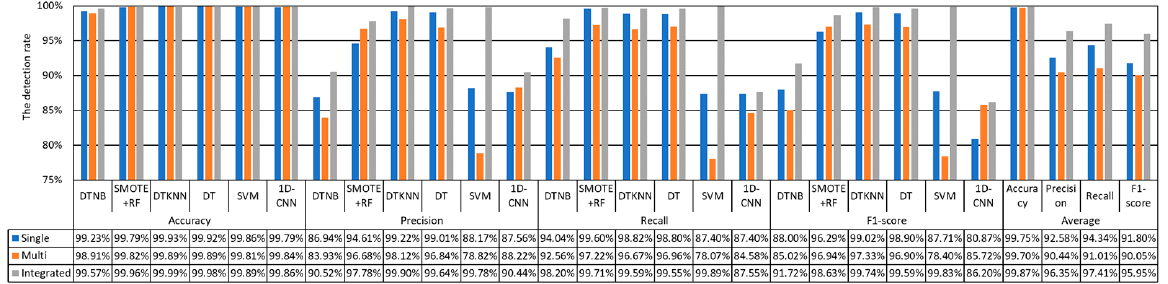
Figure 6. Detection rates in F1-score for machine learning models, according to each feature set .